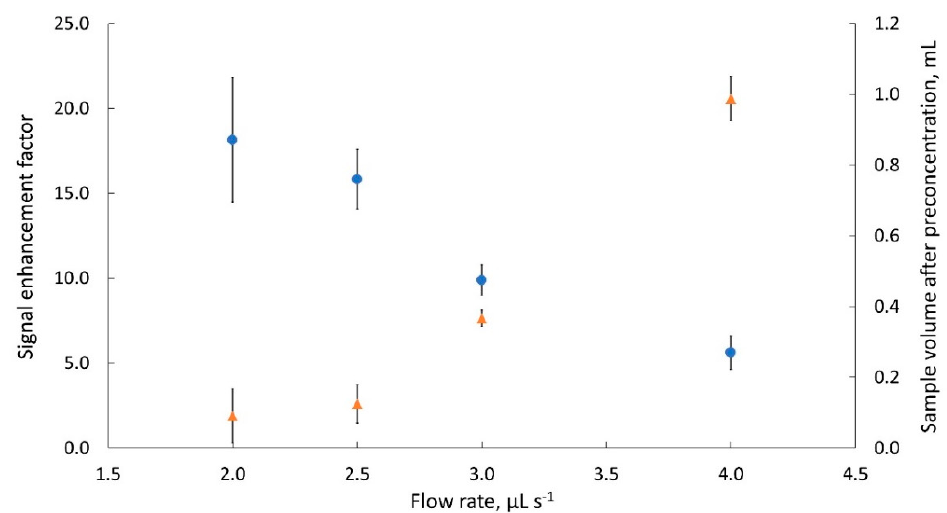
Figure 3. Dependences of the signal enhancement factor ( ● ) and of the sample volume collected after the evaporation process ( ▲ ) (with SD intervals; n = 4) depending on the sample dispensing flow rate.